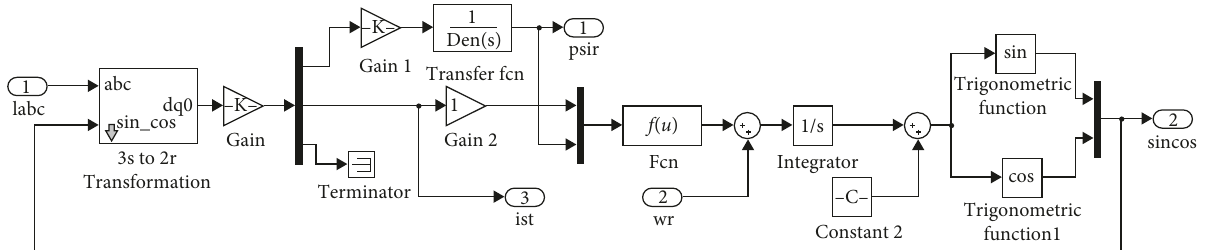
Figure 8: Current transformation and flux observation